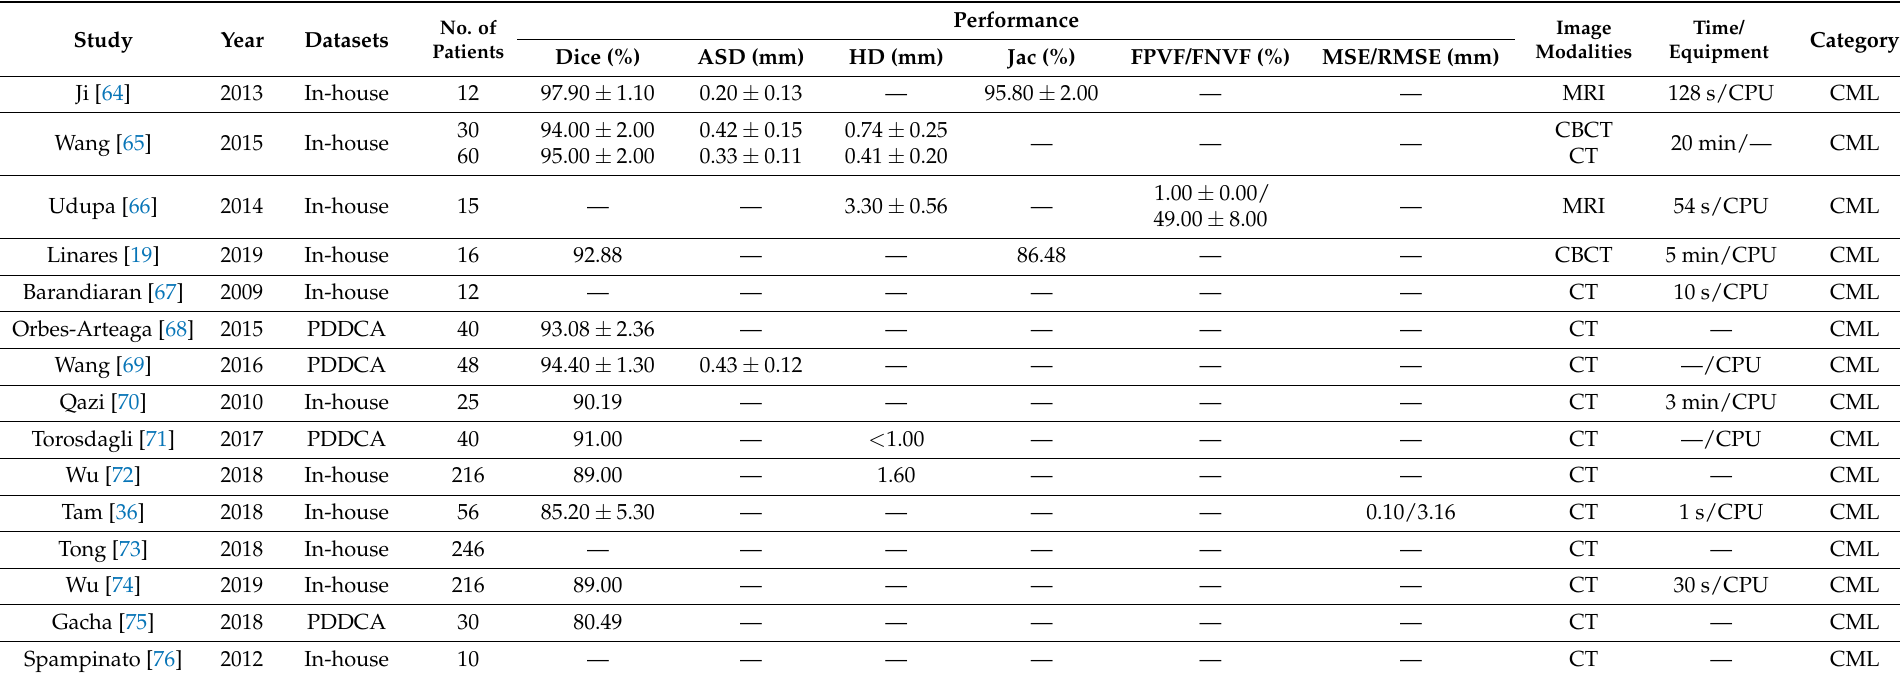
Table 6. Summary of classical machine learning-based